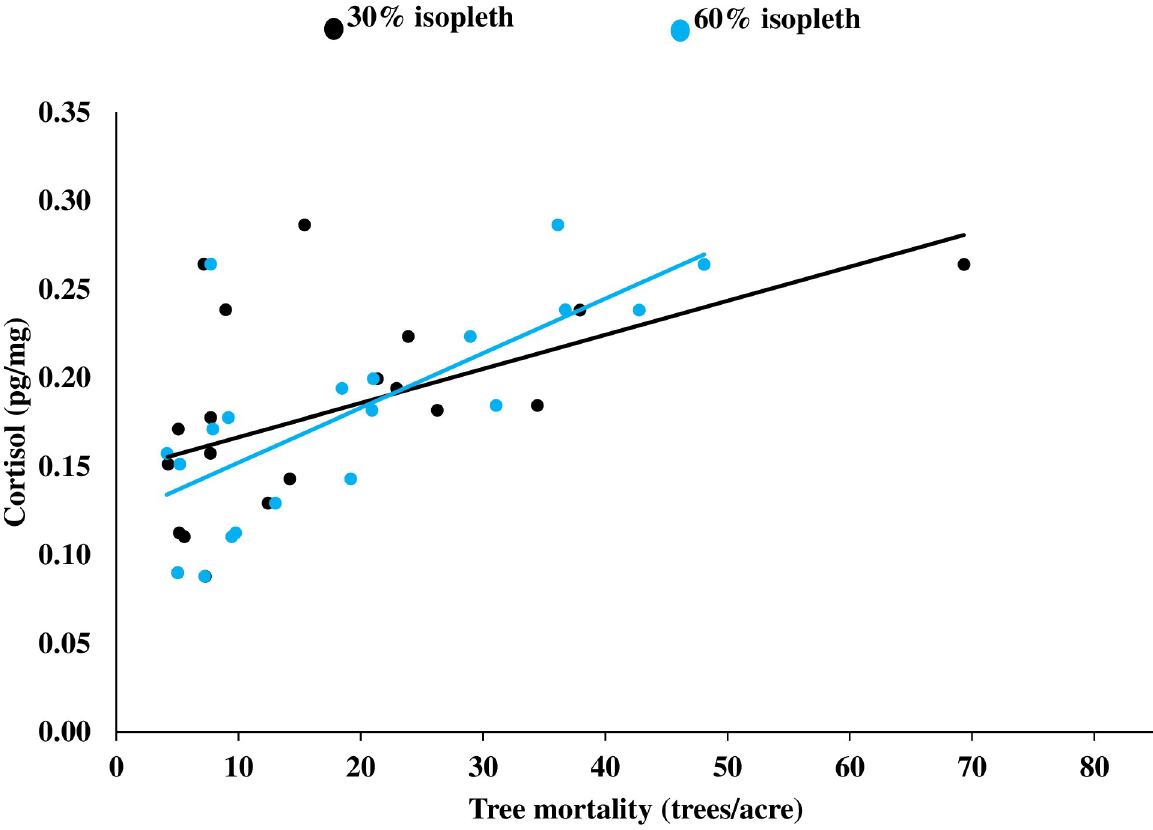
Fig 3. Relationship between cortisol (pg/mg) in hair and the amount of tree mortality (trees/acre) in the 30 and 60% kernel areas of use for male fishers, Sierra National Forest, California, USA, 2014–2016.